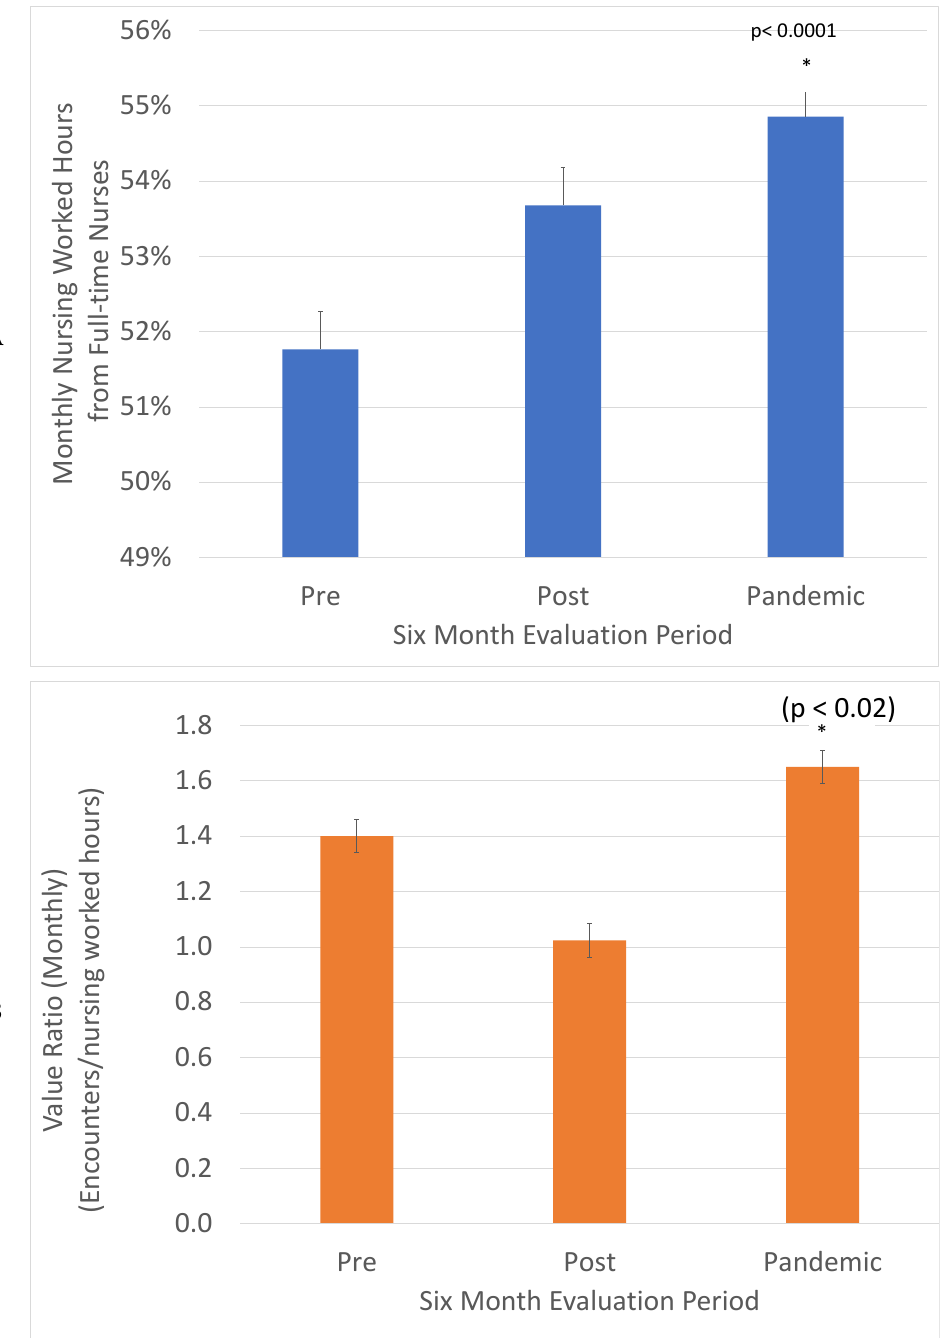
Figure 3. Value (Encounters delivered/Nursing worked hours) was increased 1.17-fold, (*) ( z test, p < 0.02) ( A ) and the percentage of nursing hours from full-time nurses increased from 52% to 55% (*) ( z test, p < 0.0001) ( B ). The total monthly encounters in each evaluation period were divided by monthly worked hours to describe value and the fraction of monthly nursing worked hours from full time nurses.